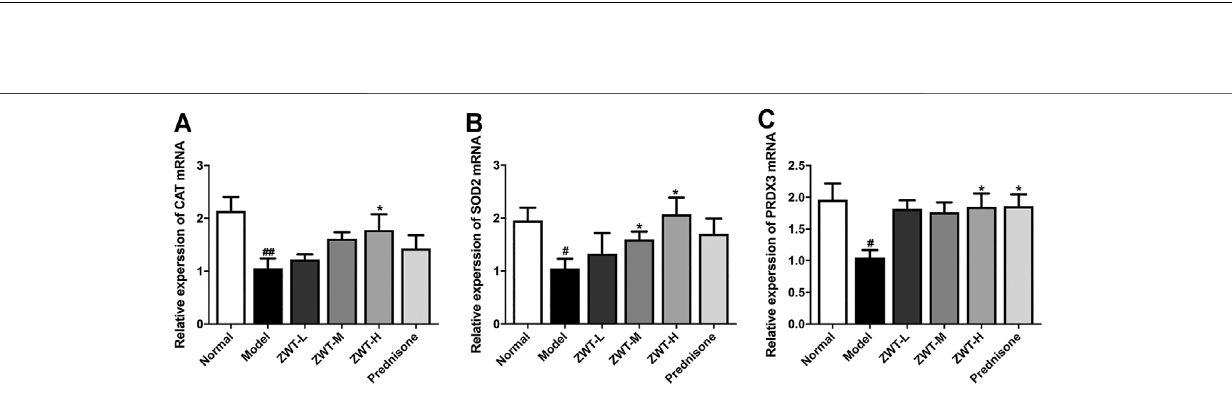
FIGURE 3 | ZWT ameliorated mitochondrial dysfunction in CGN model rats (A – C) . The mRNA expressions of mitochondrial antioxidant enzymes mitochondrial catalase (CAT), superoxide dismutase 2 (SOD2), and peroxiredoxin 3 (PRDX3) in CGN model rats by RT-PCR. Data are represented as mean ± SD ( n (cid:2) 8). # p < 0.05, ## p < 0.01 versus normal group, * p < 0.05 and ** p < 0.01 versus model group. ZWT induced mitophagy in CGN model rats.